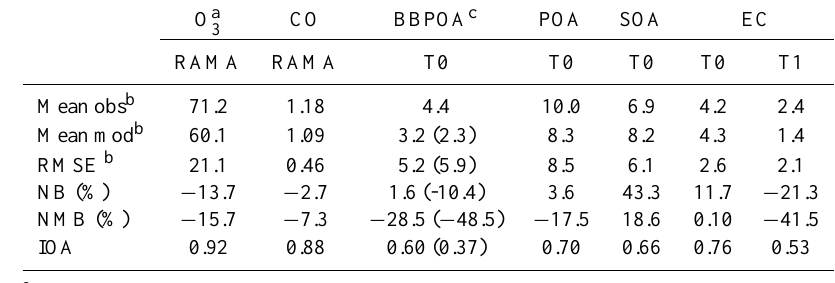
Table 3. Statistical measures of model performance during the two simulated episodes.